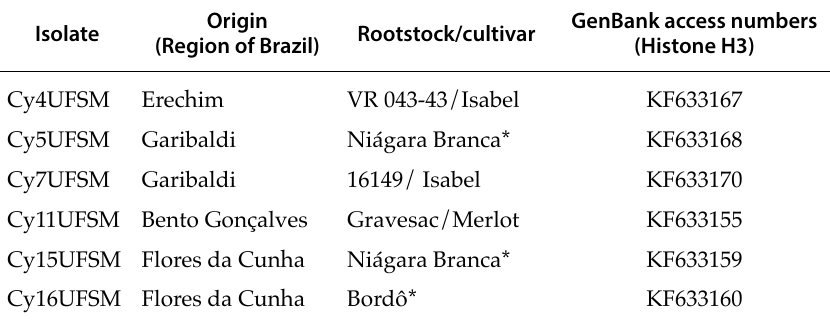
Table 1. Isolates of Dactylonectria macrodidyma used in this study. Origin Isolate (Region of Brazil)